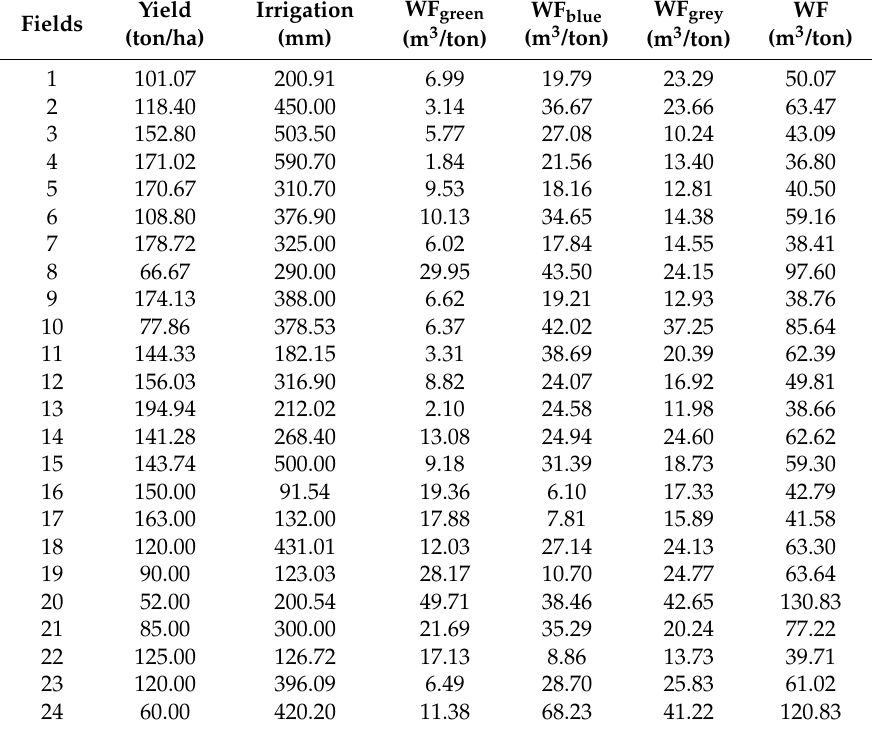
Table 2. Tomato yield, irrigation volumes and values of estimated water footprint